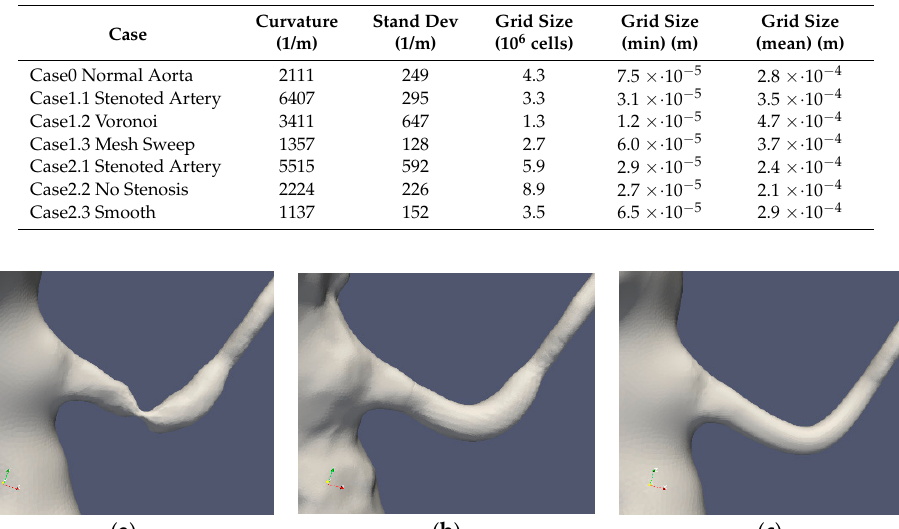
Table 1. The curvature and spatial resolution of the segmented arteries. Figure 1. The “normal” renal arteries, (Case0) ( a ), the distal stenosis (Case1) ( b ) and the proximal stenosis (Case2) ( c ).